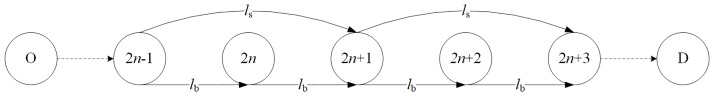
A sample bus-subway corridor.